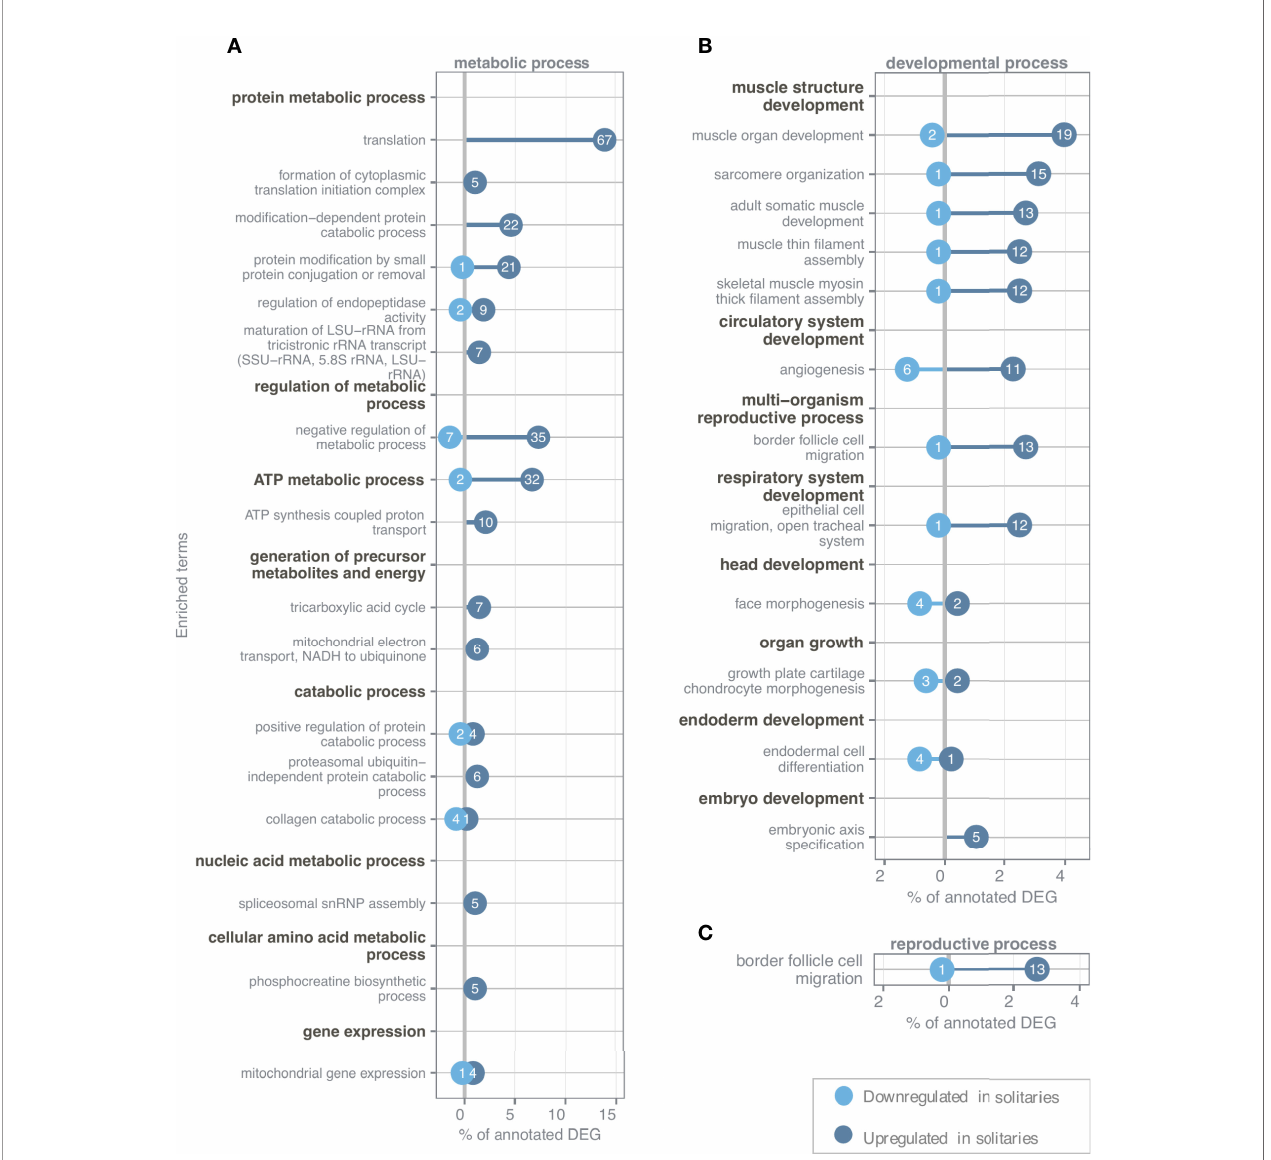
FIGURE 6 | Signi fi cant Gene Ontology terms within (A) metabolic processes, (B) developmental processes and (C) reproductive processes (within biological processes) for differentially expressed genes (DEG) between forms (solitaries vs aggregates) in winter are shown. Up- and downregulated refer to up-or downregulation in solitaries in comparison to aggregates. Only signi fi cant terms covering at least 4 DEG are shown. Numbers in circles indicate the absolute number of genes assigned to each category, while the x- axis indicates the respective percentage of all annotated DEG (480/62.18% annotation). For the sake of clarity, the terms have been manually assigned to higher-level processes (marked in